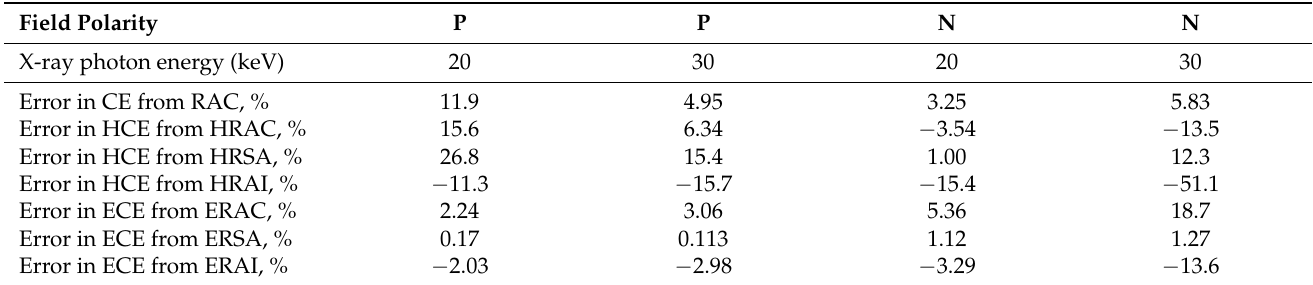
Table 3. Errors involved in the calculation of the CEs using various definitions of carrier ranges for sample S.